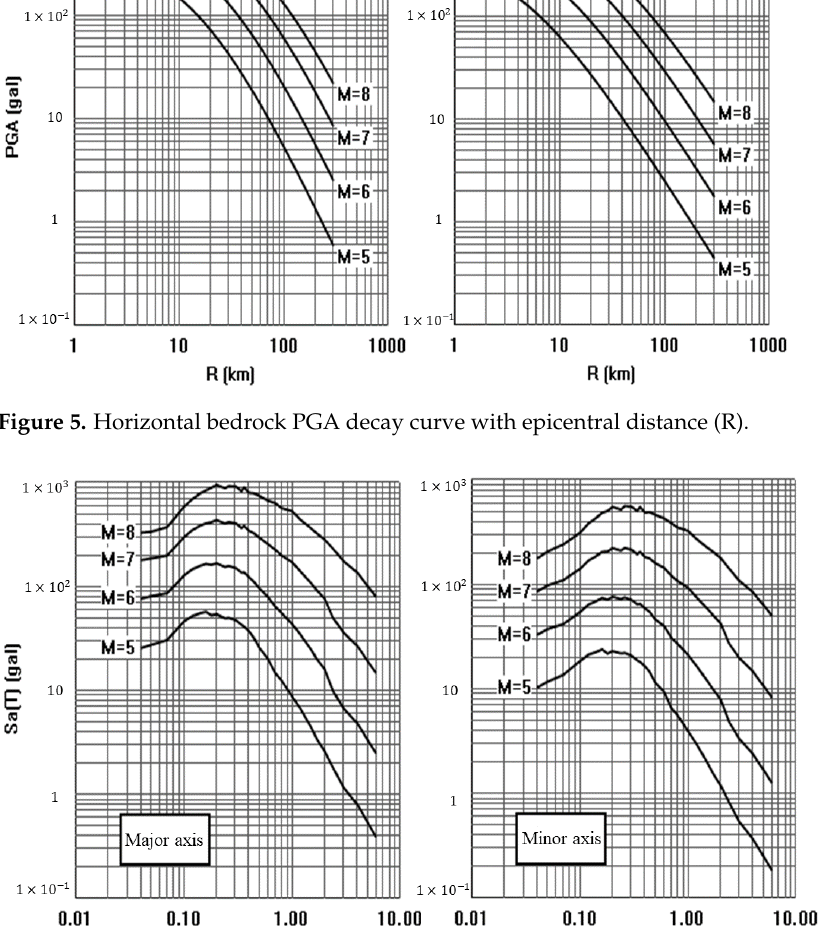
Figure 7. Attenuation curve of the response spectrum of horizontal bedrock acceleration (epicentral distance R = 100 km). 5. Conclusions This study used the probabilistic seismic hazard analysis method in Najin Lhasa and obtained the following conclusions: (1) The PSHA method divides the potential source area via specific tectonic scales, which better reflects the inhomogeneity of the spatial distribution of seismic activity. (2) The major influences on the peak acceleration of ground motion are the potential of M > 7.5 earthquakes occurring in the vicinity of the site.